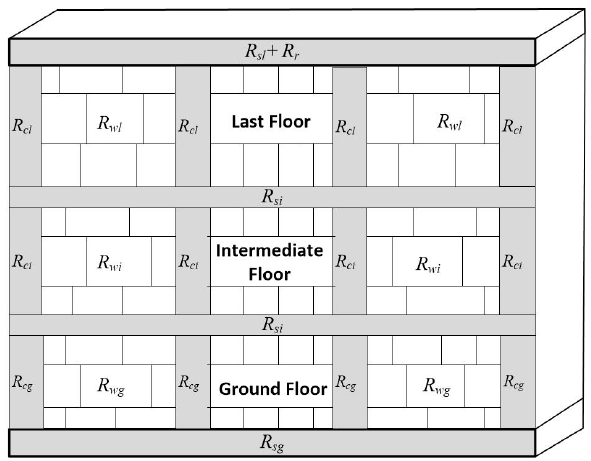
Figure 3. Illustration of the locations of the thermal resistances used in Equations (7)–(9) for the tested building envelope.